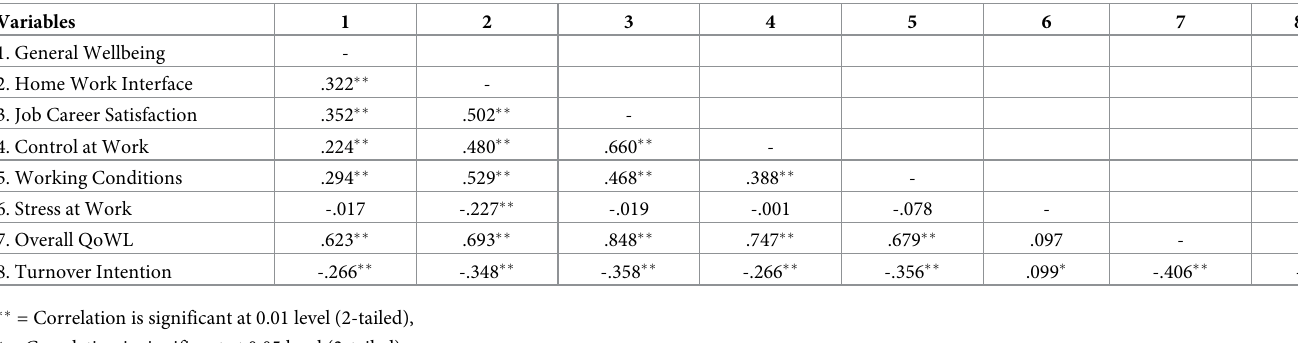
Table 4. Correlations among the QoWL dimensions and turnover intentions. Variables